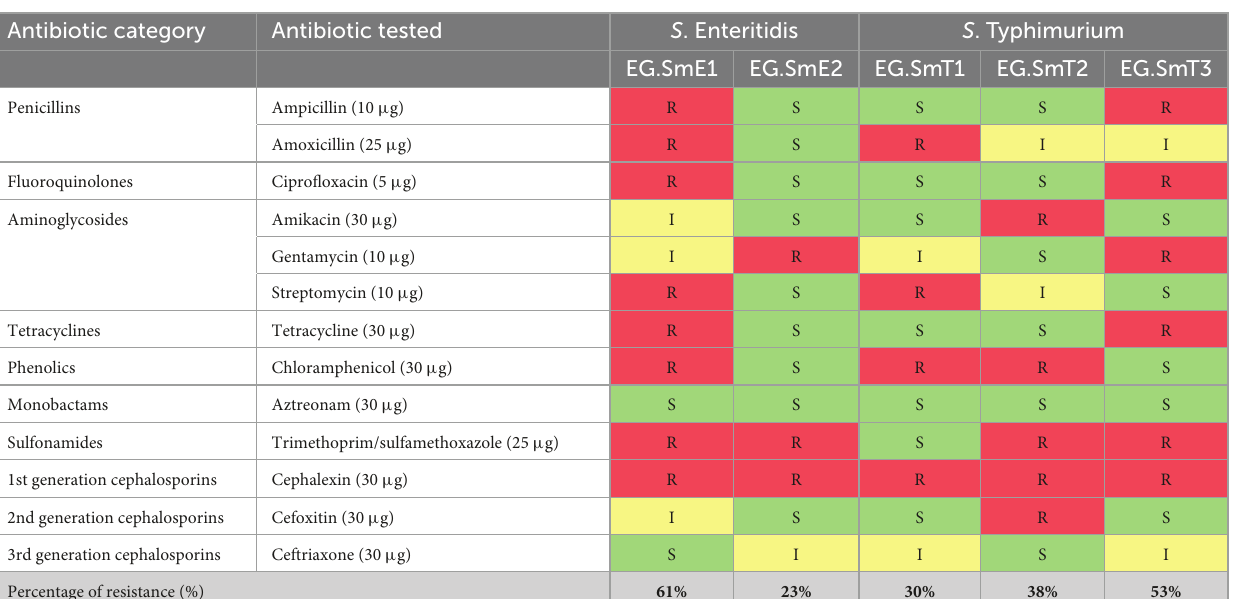
Percentage of resistance